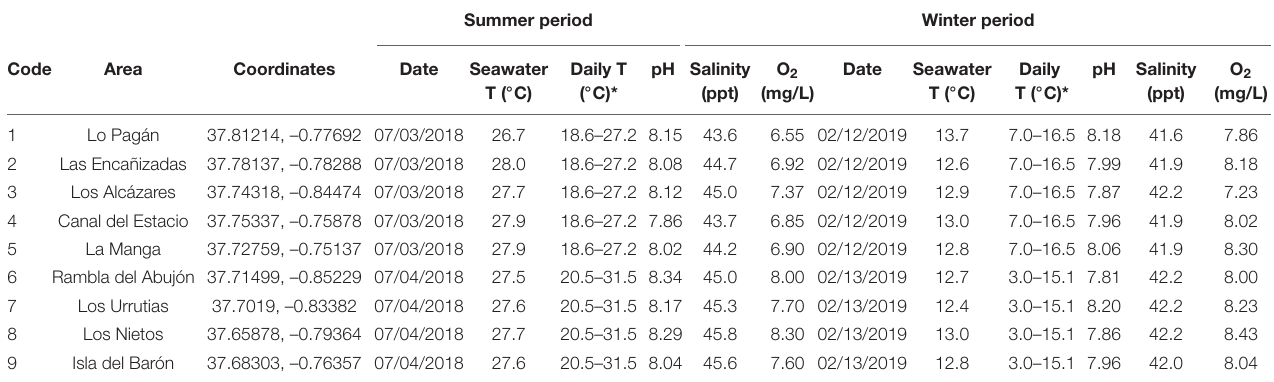
TABLE 1 | Physicochemical parameters of sampling locations during 1st and 2nd sampling